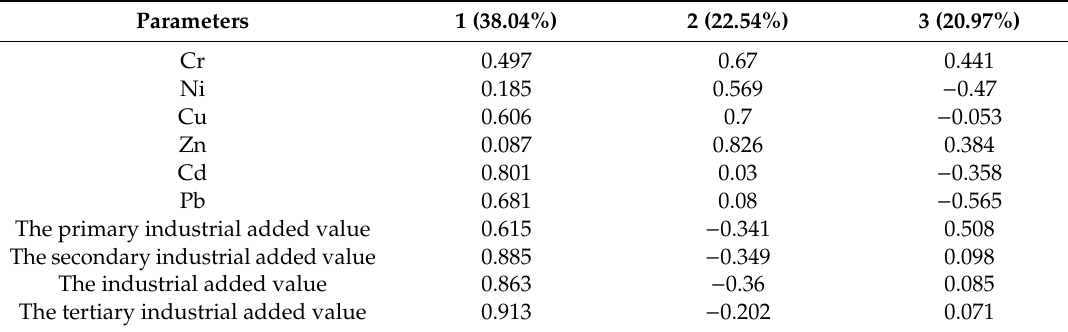
Table 4. Factor analysis of heavy metals and economic